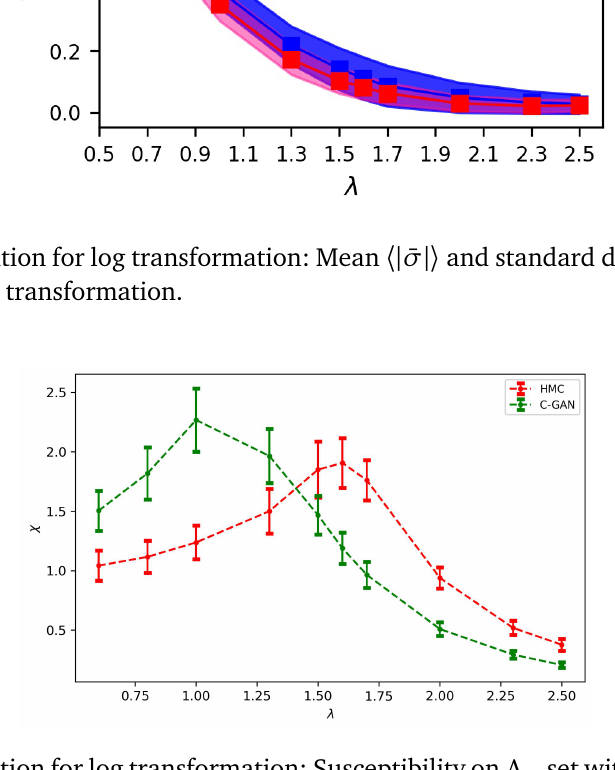
set without log trans- ts